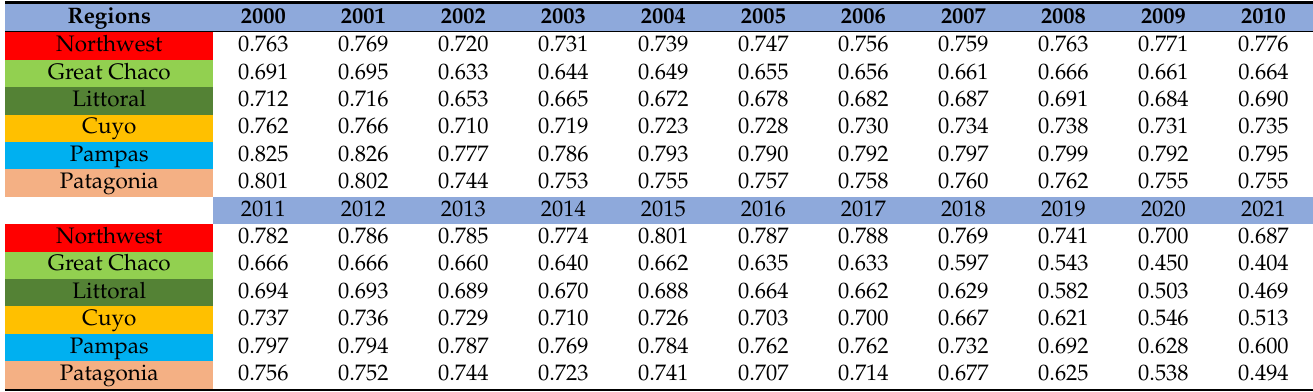
even for ˙Istanbul the share gradually declines after 2016 as a result of high devaluation. In annexed, FRI for Argentina on a yearly basis is also shown in Tables 9–12; and HDI for Turkey on a yearly basis is also shown in Tables 13–16. Table 9. Estimated Reg human development index—Argentina Table 9. Estimated Reg human development index—Argentina 2000–2021.